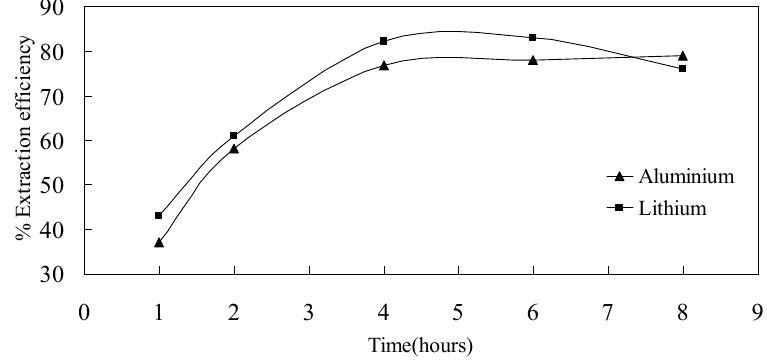
Figure 10. Effect of time on the acid leaching of DCFA (6 mol/L HCl, 120 °C, S/L ratio of 1/20).